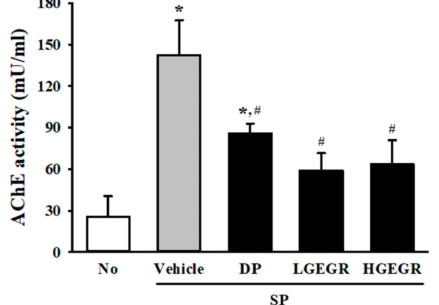
Figure 8. Measurement of acetylcholinesterase (AChE) activity in SP + GEGR treated mice. After SP treatment, AChE activity was measured in homogenates of brain tissues collected from mice in each group by using an acetylcholinesterase assay kit. This assay can detect as little as 0.1 mU AChE in a 100 µ L assay volume (1 mU / mL). Data are reported as mean ± SD values. * p < 0.05 compared with the No treated group. # p < 0.05 compared with the SP + Vehicle treated group. Abbreviation: DP, donepezil; GEGR, gallotannin-enriched extract of Galla Rhois; SP,